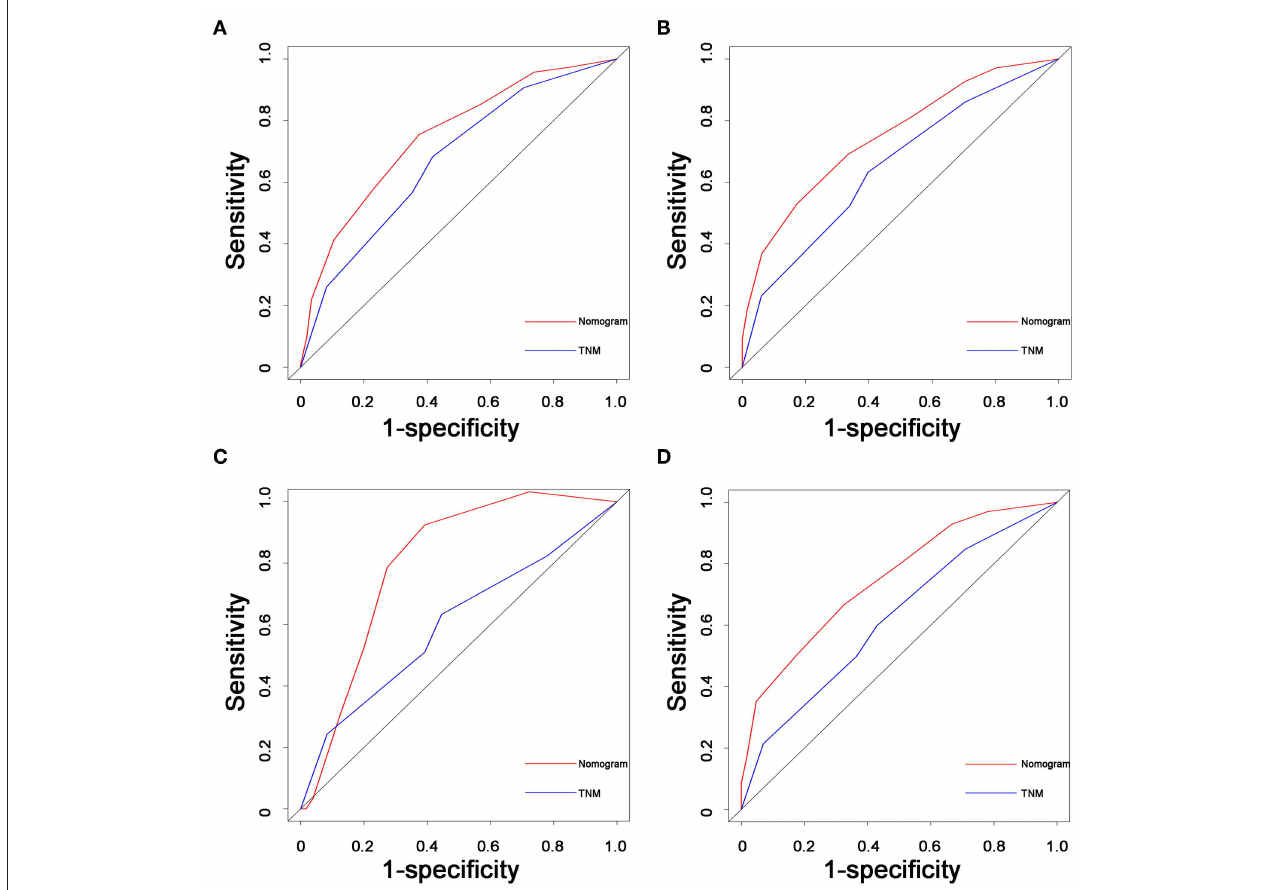
FIGURE 5 | Comparisons of receiver operating characteristic (ROC) curves of both the nomogram and TNM stage system for predicting 1- and 2-year PPS in the training cohort (A,B) and validation cohorts (C,D) , respectively. TNM, tumor–node–metastasis; PPS, post-progression survival; PDAC, pancreatic ductal